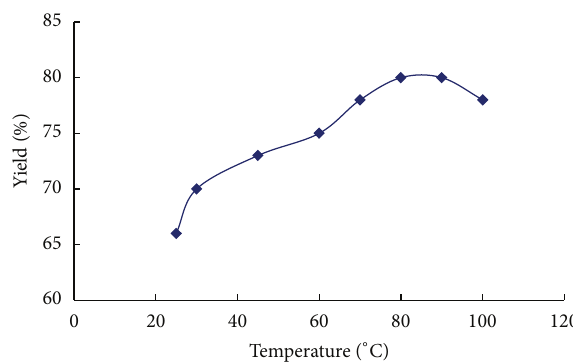
Figure 4: The effect of temperature on the yield.